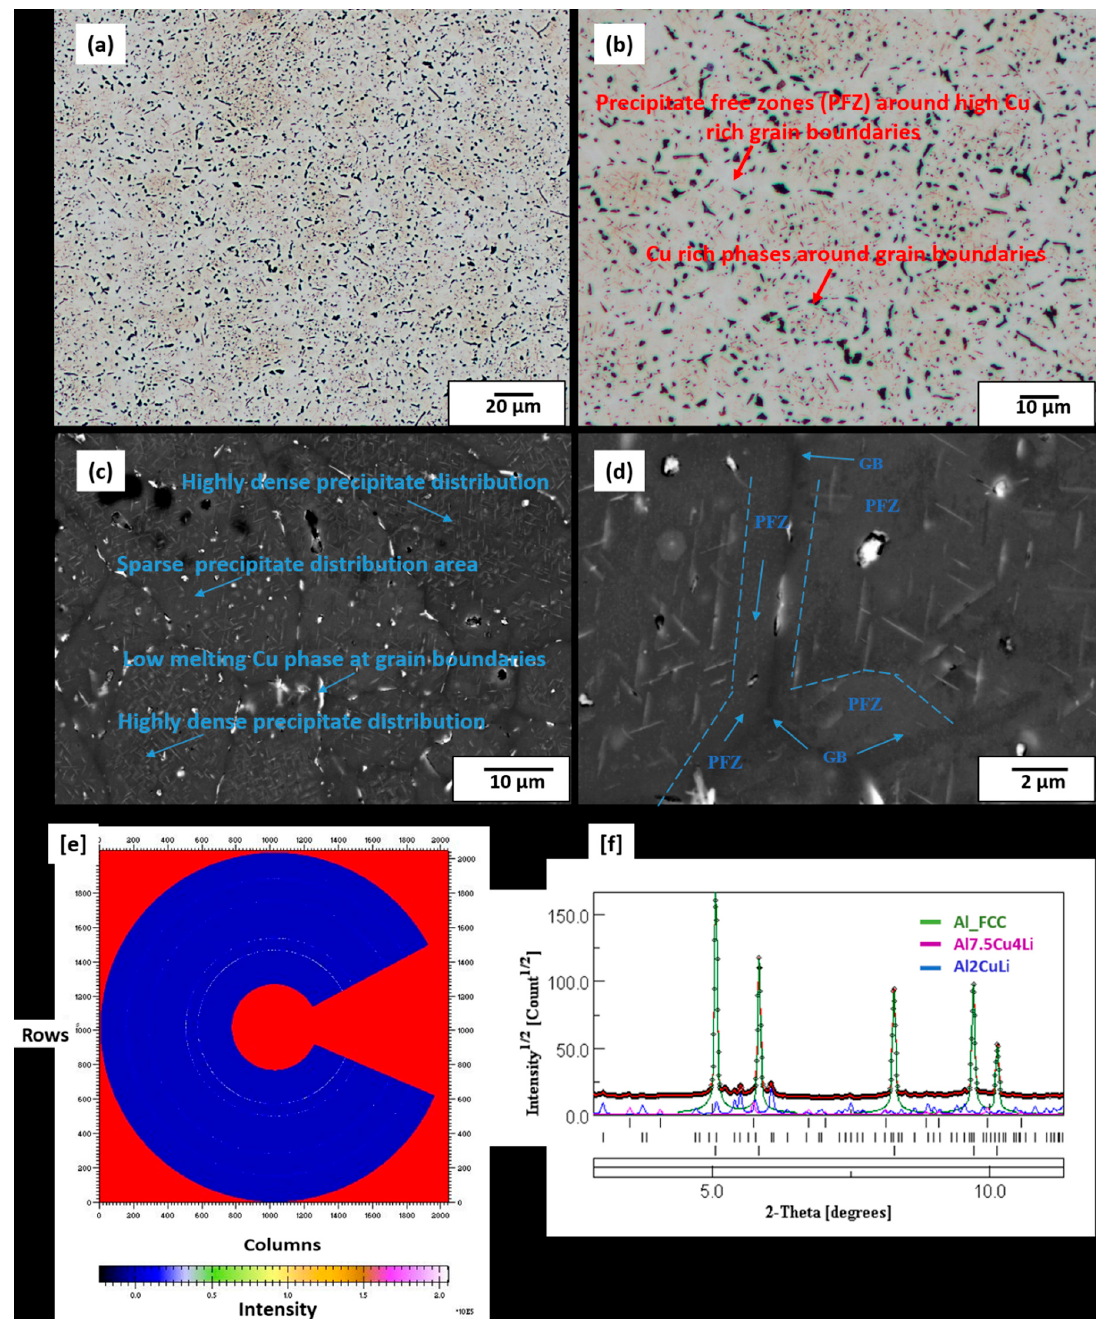
Figure 7. ( a , b ) LOM micrographs of preheat-treated sample (500 °C) showing Cu-rich phases at grain boundaries (GB), light colour: Al-rich, dark: Cu-rich, little golden (brown) rod-like precipitates. ( c , d ) SEM micrographs of preheat-treated sample (500 °C) showing rod-like precipitates suspected to be T 1 and T B precipitates of varying sizes and orientations, as well as Cu-rich phases around grain boundaries and Precipitate Free Zone (PFZ). S-HEXRD measurements (500 °C sample), ( e ) masked ring pattern, ( f ) diffraction peaks confirming the two main dominant phases, T 1 and T B .